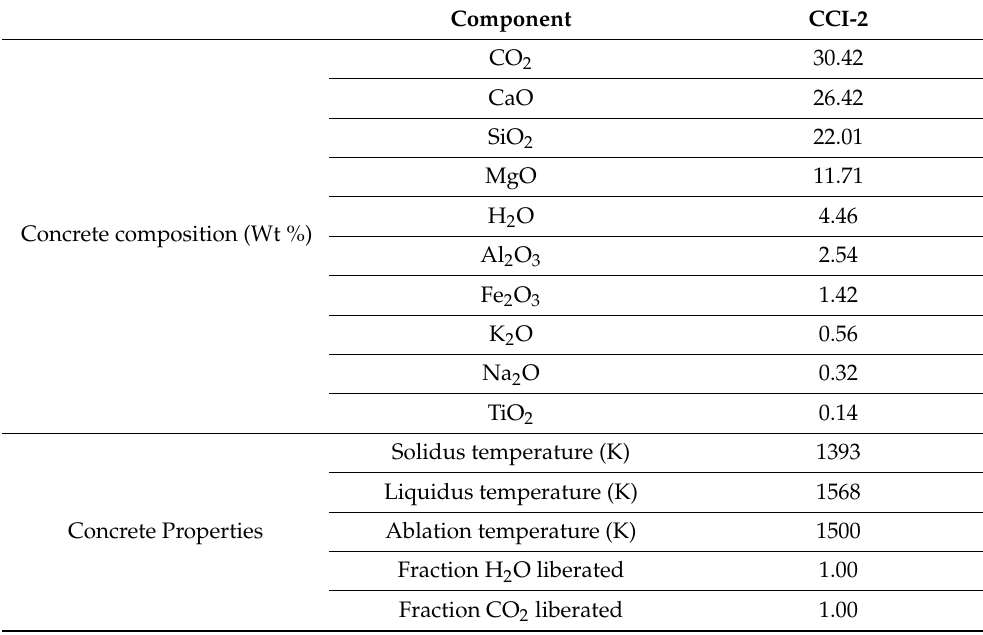
Table 2. Concrete composition and its properties for CCI-2 [2].